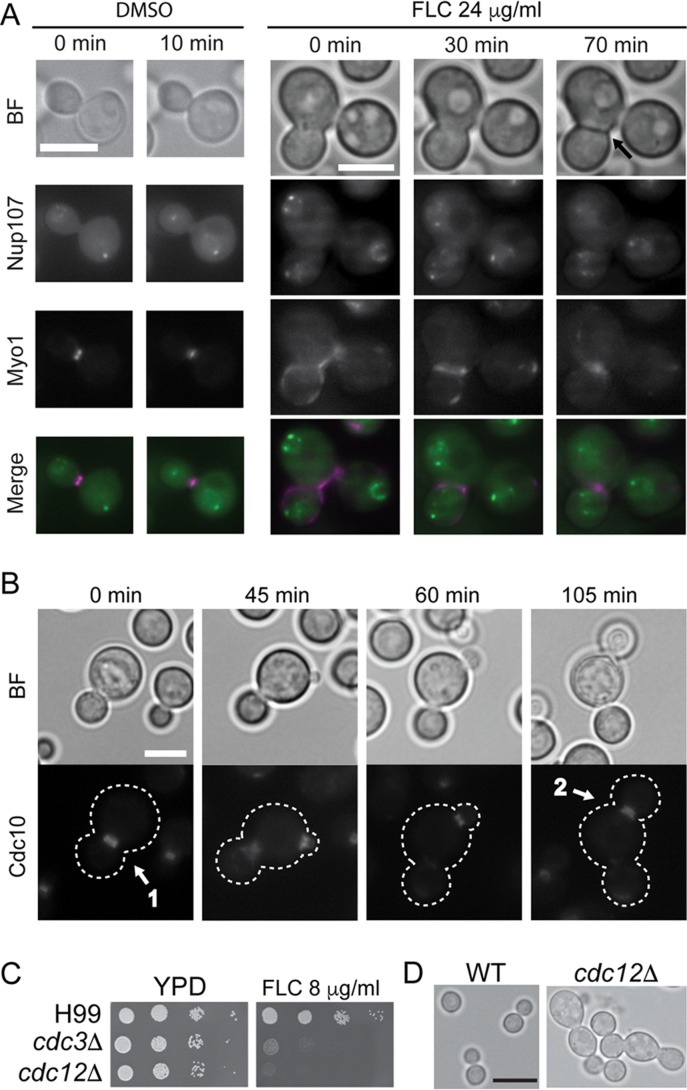
FLC does not significantly inhibit AMR assembly and constriction and septin localization. (A) To monitor constriction of the AMR, time-lapse microscopy was performed using a strain that expressed a component of the AMR, myosin heavy chain (Myo1), tagged with mCherry, and a nucleoporin (Nup107), tagged with GFP (to monitor the stage of mitosis; strain LC4). Cells from the control treatment (DMSO) had a constricted AMR. FLC-treated cells that formed multimeras also constricted the AMR, although the dynamics of the constriction differed significantly from those seen with untreated control cells. The arrow in the uppermost of the panels corresponding to the 70-min time point indicates a dark line that likely corresponds to a septum formed after the AMR had constricted. Bars, 5 µm. (B) Cells expressing septin Cdc10-mCherry (LK62) were pretreated with 24 μg/ml FLC for 6 h, and the localization of Cdc10-mCherry was analyzed by time-lapse microscopy while the cells were continually exposed to FLC (the times indicated represent the progression of the time lapse). Cdc10-mCherry formed a collar and a double ring between the mother and the first daughter (arrow 1) and formed another such ring when the second daughter was formed (arrow 2). (C and D) Cells deleted for Cdc3- or Cdc12-encoding genes (LK65, LK162) exhibited hypersensitivity to FLC (C), with a clear defect in cytokinesis at 24°C (D). Bars, 5 µm in panels A and B and 10 µm in panel D.